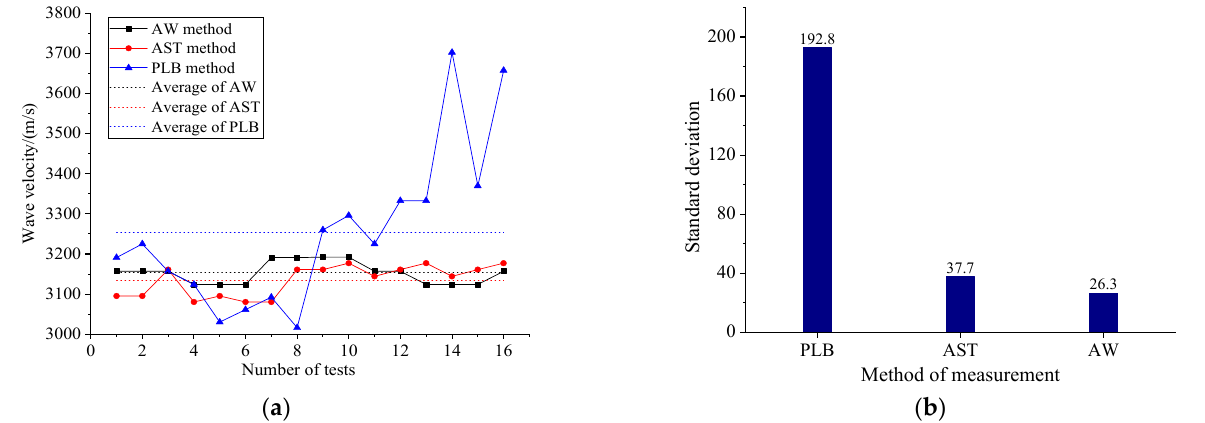
Figure 10. ( a ) Results of three wave velocity measurement methods. ( b ) Standard deviation of three wave velocity measurement methods.